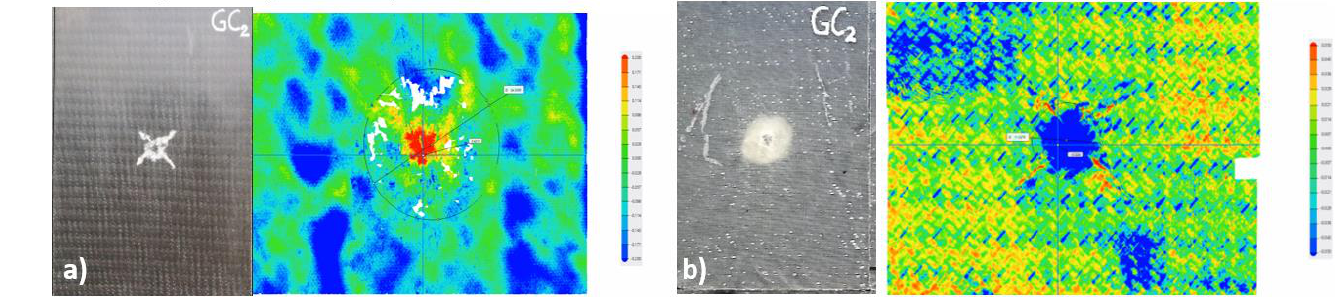
Figure 9. ( a ) Front, ( b ) back sides laser scan measurements of sample GC2 damaged area.